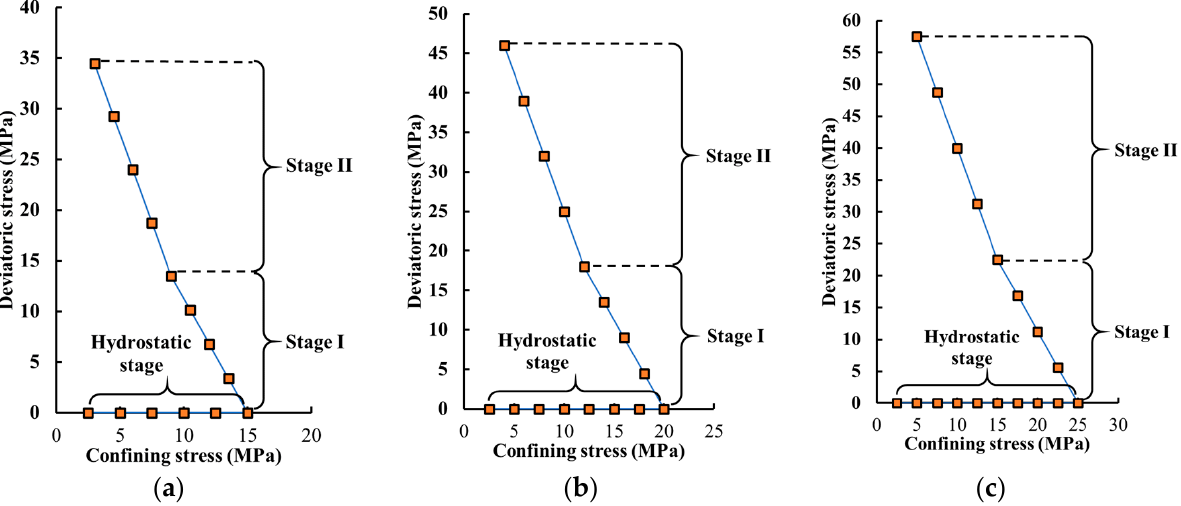
Figure 3. Loading schemes of different sandstone samples (( a – c ) are the initial confining pressure of 15 MPa, 20 MPa, and 25 MPa, respectively).